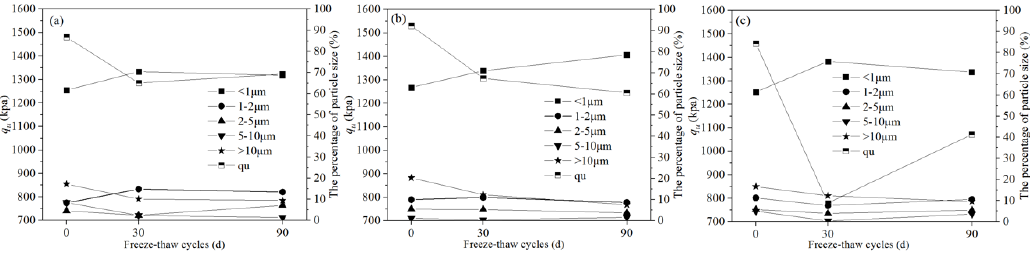
Figure 16. The q u and particle size distribution of Pb-CSCSs: ( a ) C2.5S5F5; ( b ) C5S2.5F2.5, and ( c ) C5S5.